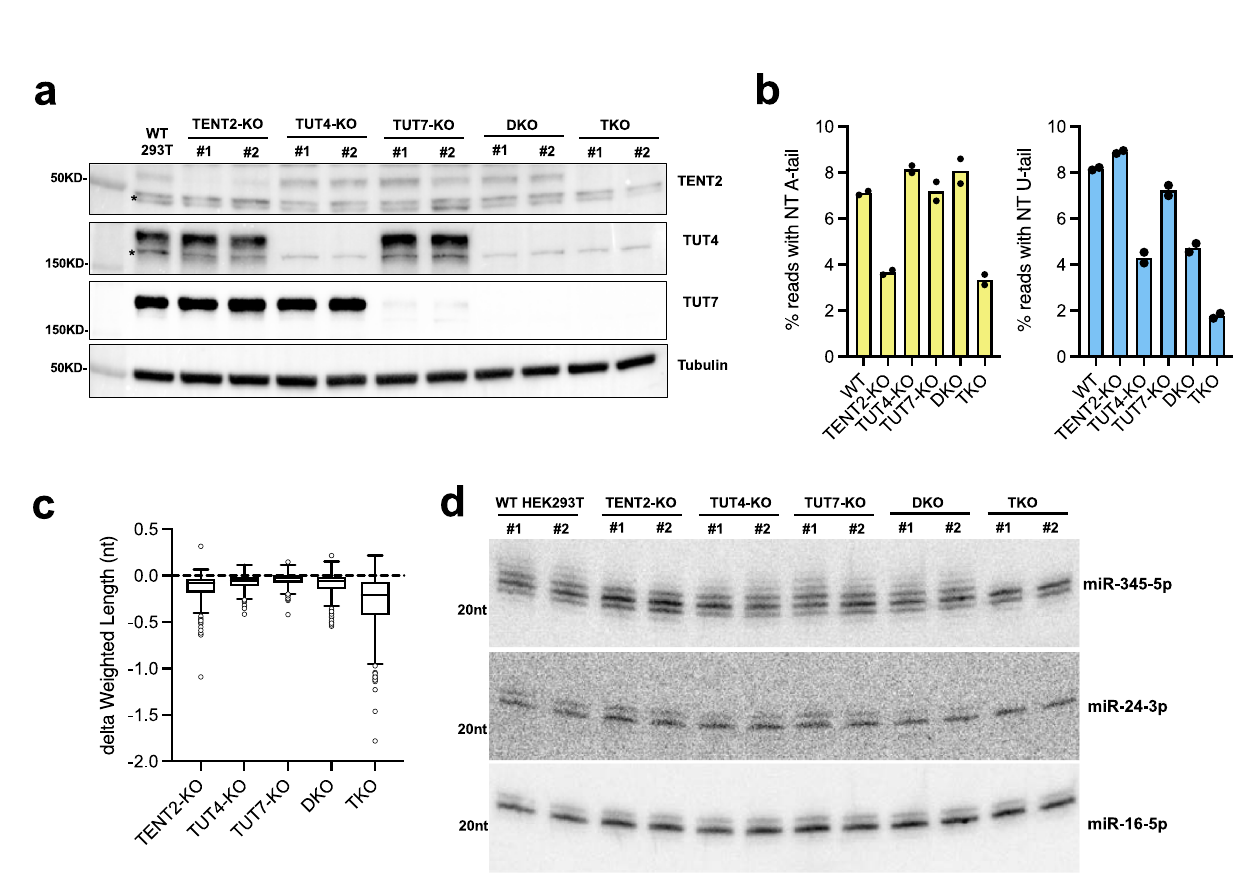
Fig. 1 | miRNA 3 ′ tailing is frequent and speci fi c. Analyses of the top 200 most expressed miRNAs (top 100 5p and top 100 3p miRNAs). a Pie chart on the 3 ′ -end composition(percentages). b NucleotideidentityonNTtails(averagepercentage± standard error, N =200 miRNAs). c Nucleotide identity on NT tails and tail length. Column height represents the percentage of NT tail while colored areas represent thecorrespondingfractionbasedonnucleotideidentity.U_tailandA_tailrepresent uridylation and adenylation homogenous tailing, whereas Mixed includes hetero- geneous tailing and other nucleotides (Average ± standard error, N =200 miRNAs,